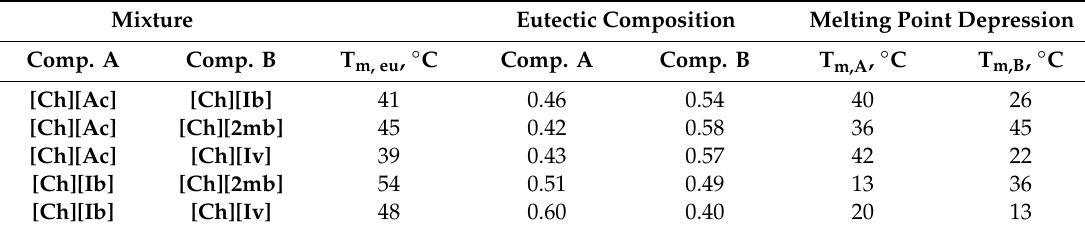
Table 3. Properties of eutectic compositions of choline ILs in this study. Mixture Eutectic Composition Melting Point Depression